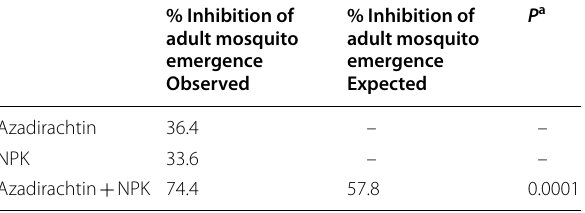
The statistical comparison between observed and expected mortalities was achieved using a Fisher exact test